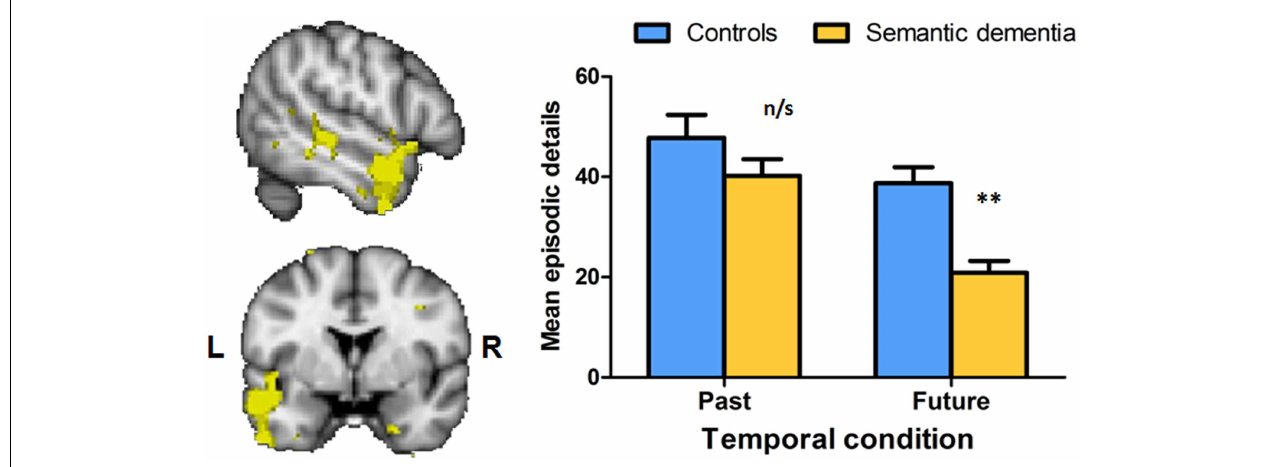
FIGURE 3 | Deficits in future thinking in semantic dementia are exclusively associated with gray matter intensity decrease in the left anterior temporal lobe, as revealed by voxel-based morphometry analyses. Clusters are significant at P < 0.001 and overlaid on the Montreal Neurological Institute standard brain. Error bars represent standard error of the mean. ** P < 0.0001; n/s, not significant. Figure adapted from Irish et al.